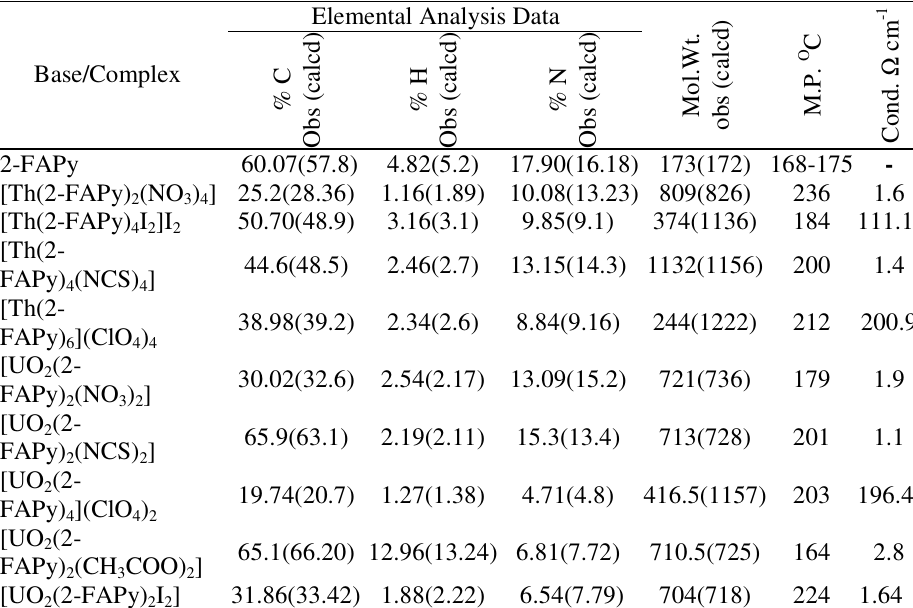
Table 1. Analytical results of 2-FAPy and its complexes. Elemental Analysis Data